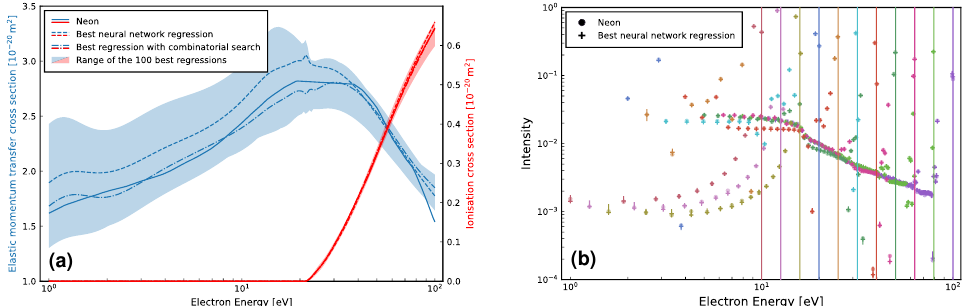
Figure 4. Simultaneous neural network regression of Ne’s elastic MTCS and ionisation cross- sections [90], ( a ), and the corresponding agreement, ( b ), between its simulated EELS and the EELS used to perform the fit. The vertical lines in ( b ) denote the initial energies for each of the eleven EELS considered (from 10 eV to 100 eV incident energy, inclusive). Additionally, a shaded area in ( a ), along with vertical error bars in ( b ), are provided to indicate the range of the 100 best regressions. See also the figure legends for further details, noting that black is used to represent each colour of that marker shape, where colours correspond to each initial electron energy of 100, 79.43, 63.1, 50.12, 39.81, 31.62, 25.12, 19.95, 15.85, 12.59 and 10.0 eV, indicated by vertical lines. In this model, a bias vector size of 128 was used along with 300,000